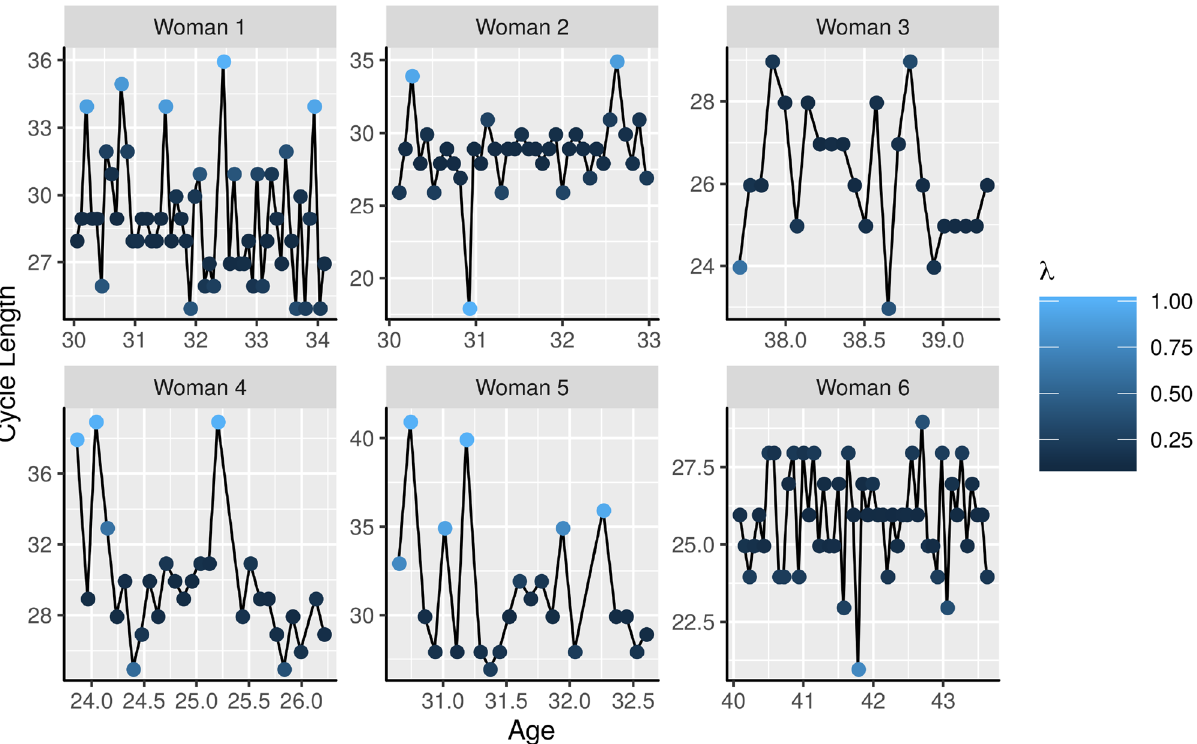
Figure 2. Example of six women profiles showing the probability that the proposed model considers an observation as overdispersed, where (cid:31) represents the probability of (cid:31) ij being equal 1 for a given